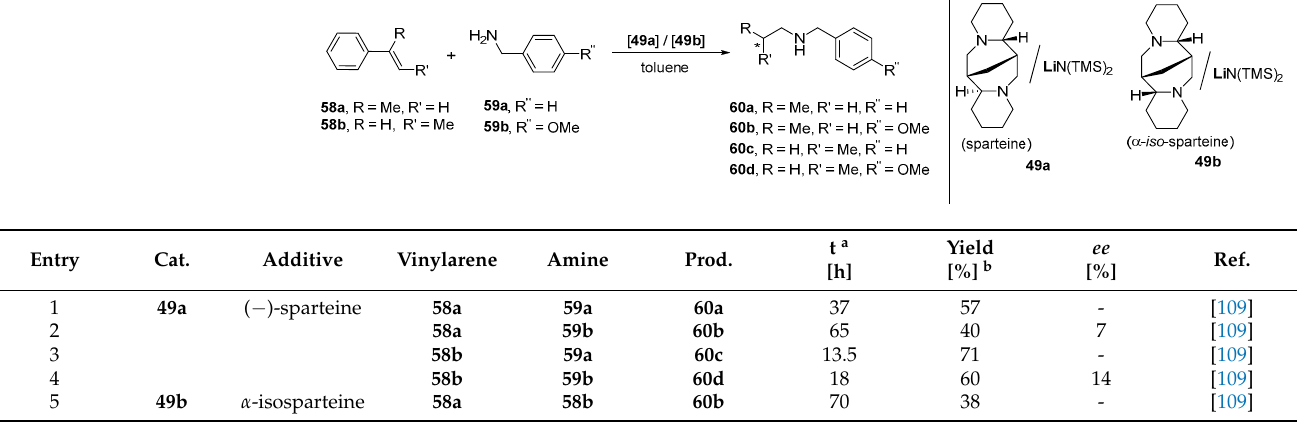
additive, and 0.1 mL of toluene at 120 °C. b Isolated yield by column chromatography. Outside of the chiral pool, Deschamp et al., reported a non-chiral-pool-based di- amidobinaphthyl building block, allowing the variation in alkyl and methylene-aryl substituents at the amino functionalities [111,112]. Addition of LiCH 2 SiMe 3 to the re- spective N , N’ -disubstituted binaphthyldiamine resulted in the corresponding